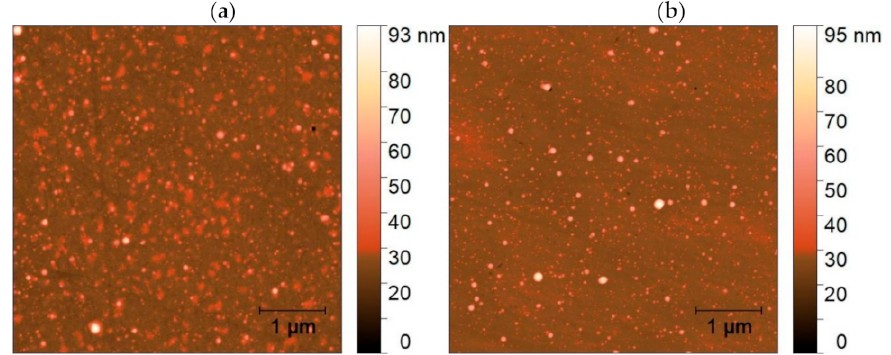
Figure 12. AFM surface images of Lu 2 O 3 :Eu thin film ( a ) as deposited and ( b ) after PLA processing, seven